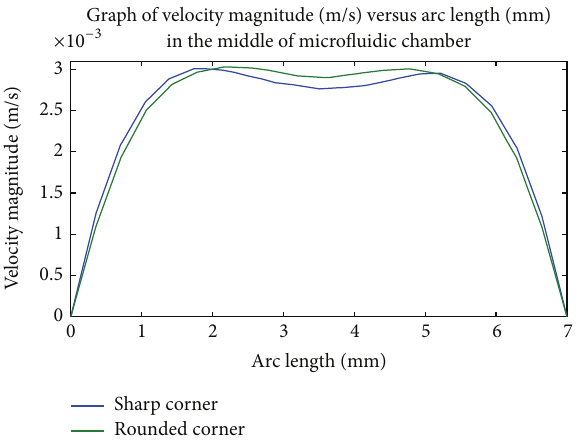
Figure 10: Comparison of average velocity across the width of microfluidic chamber for rounded corner and sharp